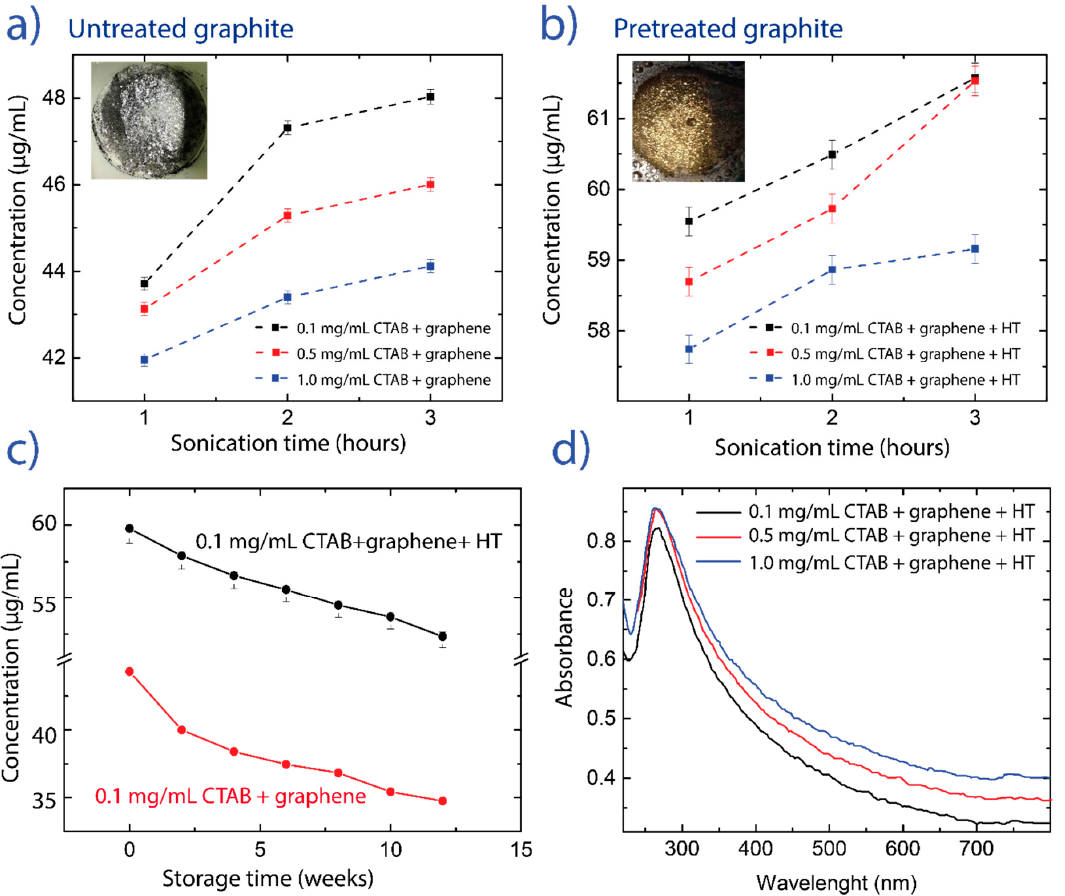
Figure 1. Concentration of dispersed graphene as a function of three different hexadecyltrimethylammonium bromide (CTAB) concentrations (0.1, 0.5, 1.0 mg/ mL − 1 ) at three different sonication times, from ( a ) pristine (untreated) graphite and ( b ) treated graphite by the hydrothermal treatment (HT). ( c ) Stability of the graphene dispersion in 0.1 mg/ mL − 1 of the CTAB aqueous solution as a function of the storage time, considering pristine and pretreated graphite source. ( d ) UV-visible spectra of exfoliated graphene in the three different CTAB concentrations after HT and 3 h of sonication. Optical photos of pristine graphite ( a , inset) and pretreated graphite ( b , inset). Independently of the CTAB concentration (0.1, 0.5 and 1.0 mg mL